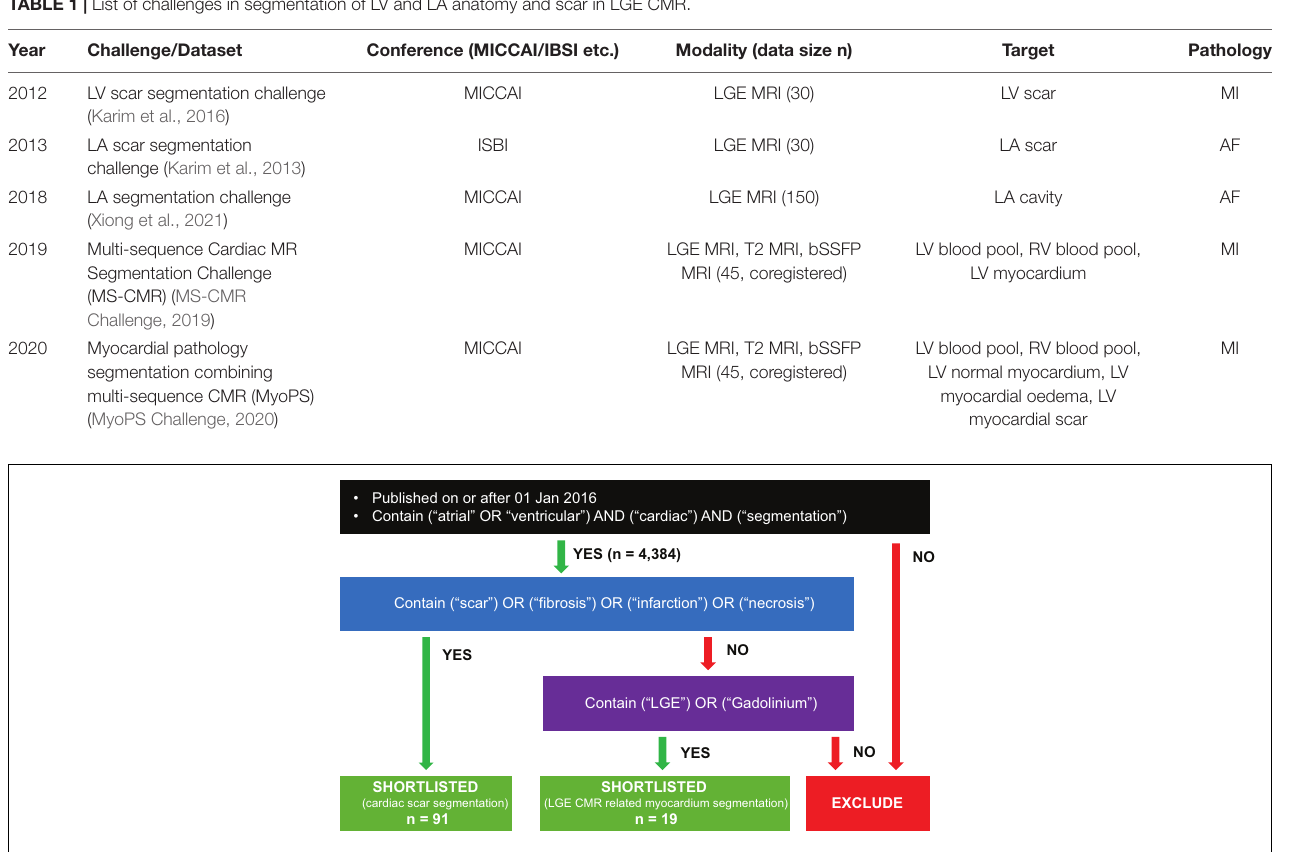
FIGURE 1 | Flowchart to demonstrate the search